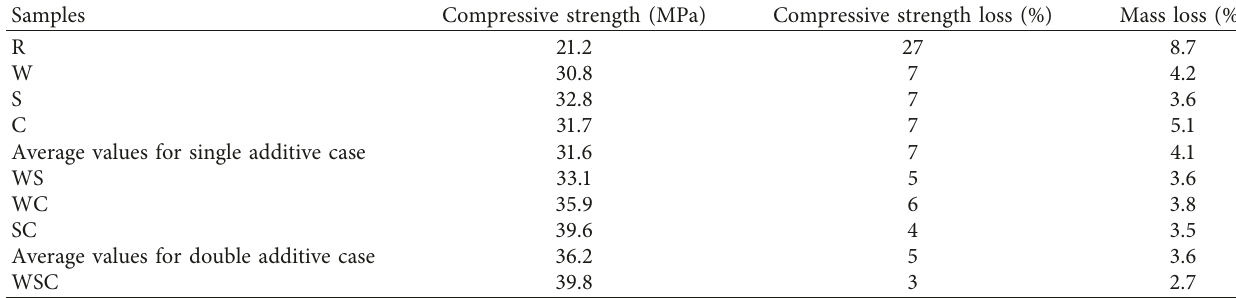
Table 9: Mass and compressive strength losses after freeze-thaw tests.